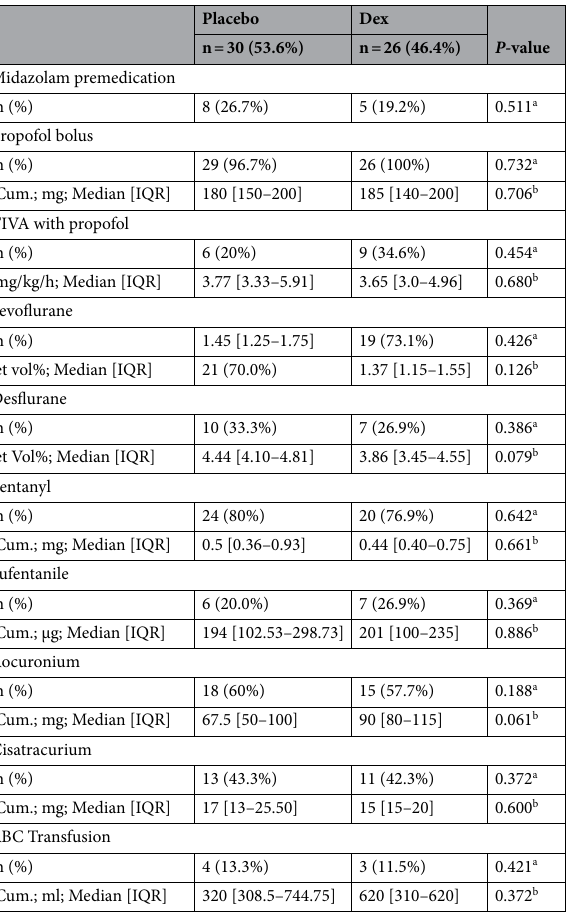
Table 2. Intraoperative opioid, anaesthetic and transfusion requirements of 56 patients. Statistical analysis was conducted between patients receiving standard general anaesthesia (Placebo) and dexmedetomidine in addition to general anaesthesia (Dex). Cum . cumulative dose in all patients, Dex Dexmedetomidine, IQR Interquartile range. n (%) number of patients who received the drug or transfusion at least once (expressed as percentage), RBC red blood cell, TIVA totally intravenous anaesthesia. a Categorical variables analysed by Chi